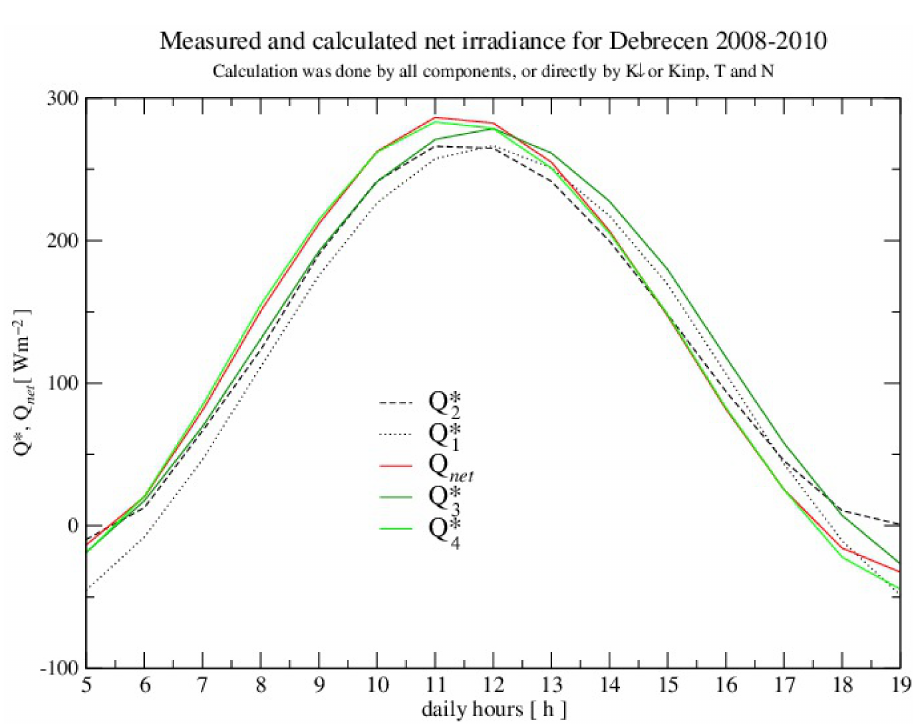
Figure 8. Mean annual daily variations of the measured Q net and calculated net irradiances: Q ∗ Q ∗ and Q ∗ 3 4